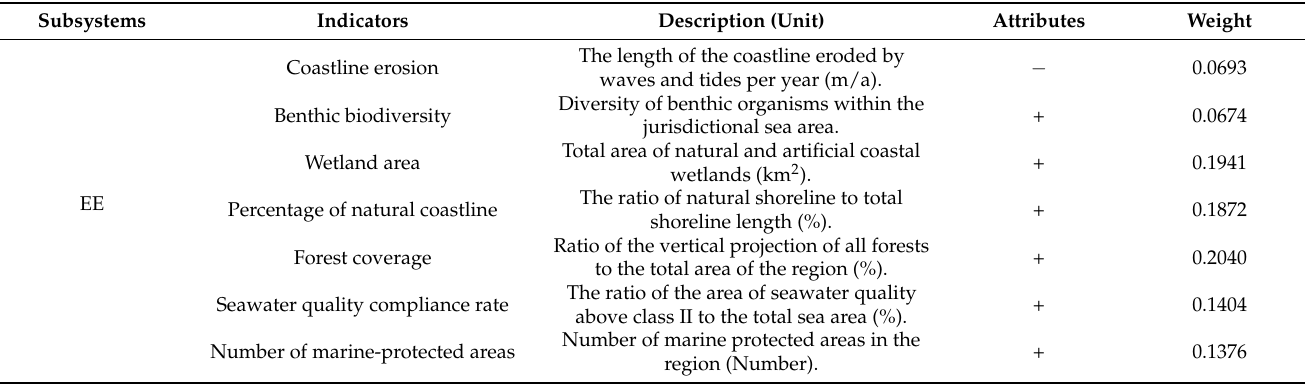
Figure 2. Causal relationships among factors of the coastal zone system: The first quadrant is the region with the highest P i and R i , indicating that not only each factor in this region has a great influence on the system, but also each factor has a large influence on the other factors. Therefore, all factors in this quadrant can be used as the key influence factors of the system (blue dots); R i in the fourth quadrant is low but P i is high, indicating that each factor in this quadrant has limited ability to influence the other factors, but has a greater impact on the system. Therefore, all factors in the fourth quadrant also serve as key influencing factors of the system (blue dots); The P i and R i of the second and fourth quadrants are low and have limited influence on the system and other factors, so they are not considered as the key influence factors (red dots). Table 3. Coastal zone subsystem evaluation indicator